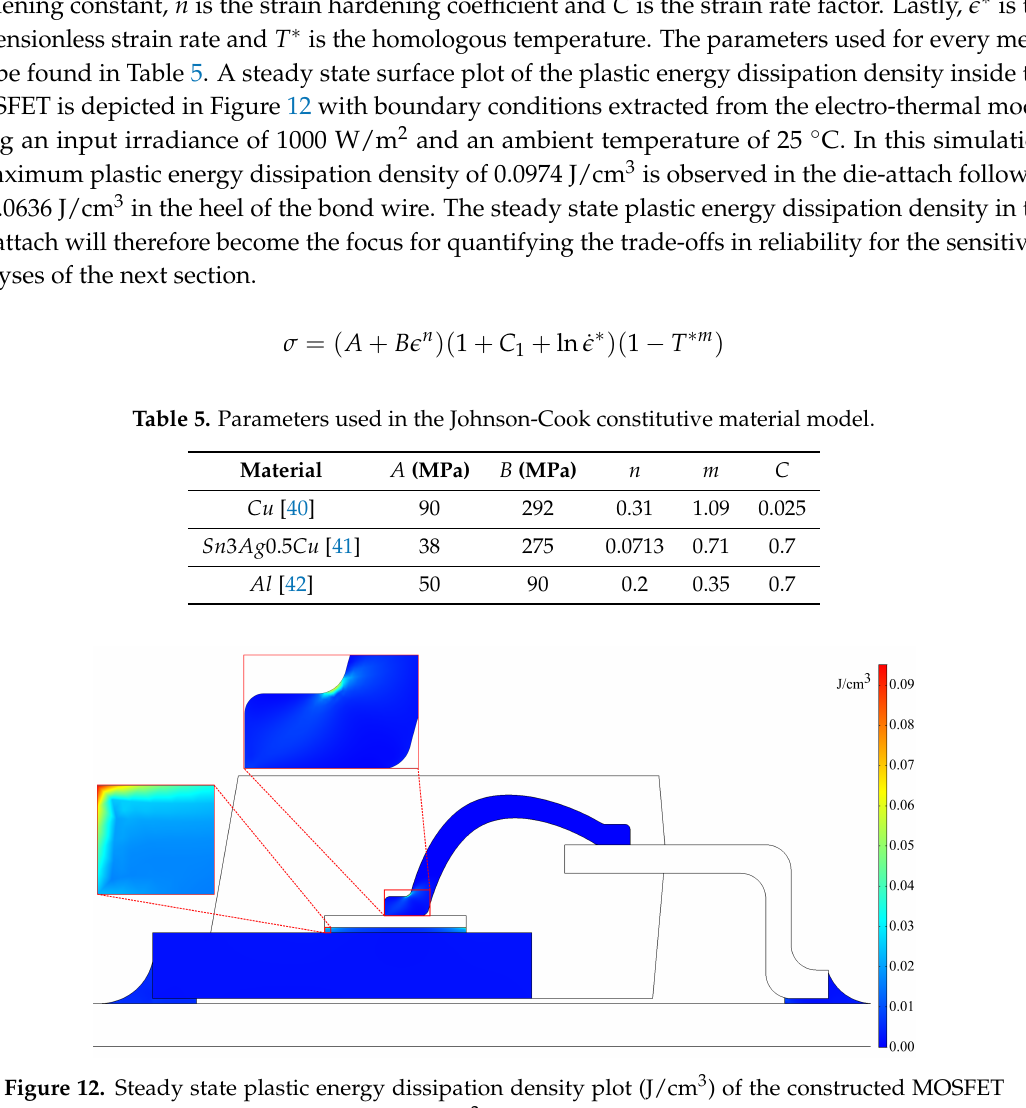
Figure 12. Steady state plastic energy dissipation density plot (J/cm 3 ) of the constructed MOSFET FEM model resulting from a load of 1000 W/m 2 on the solar panel at 25 ◦